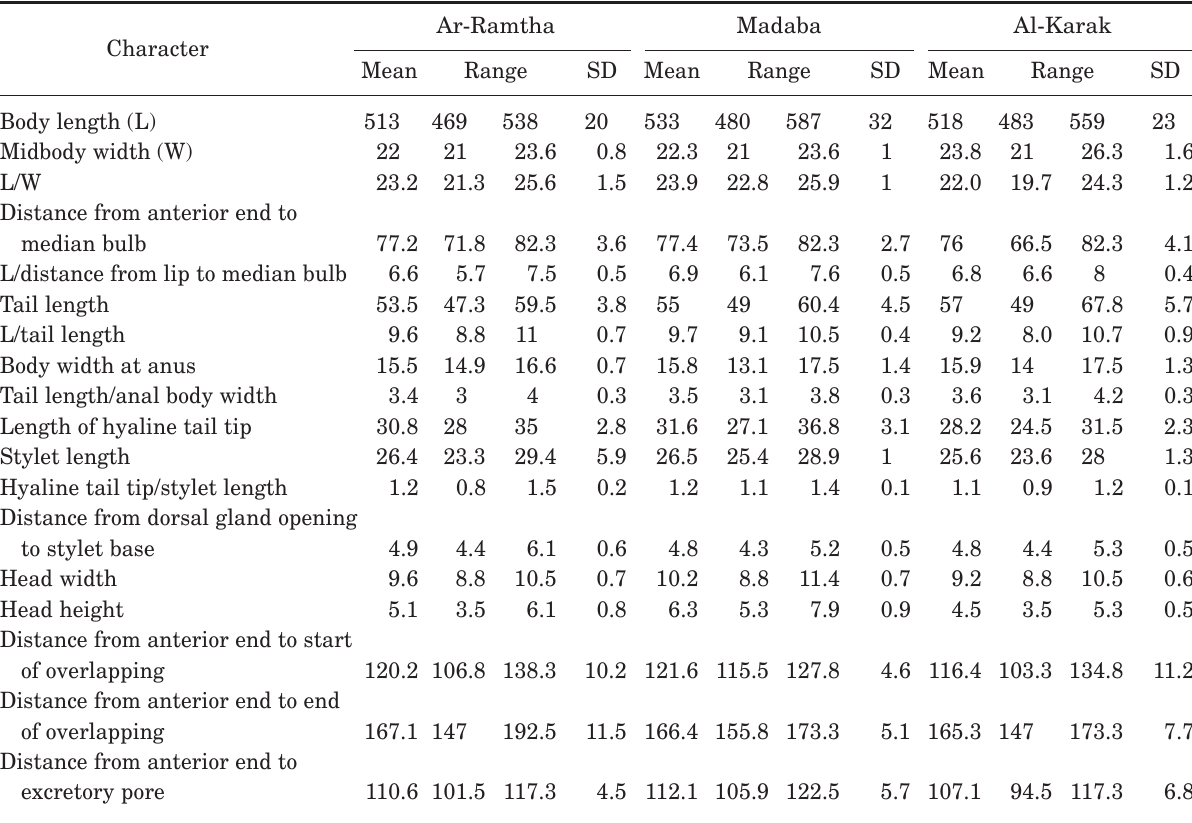
Table 3. Morphometric data (µm or ratio) of second-stage juveniles (n=10) of three Heterodera latipons isolates. Ar-Ramtha Madaba Al-Karak Character